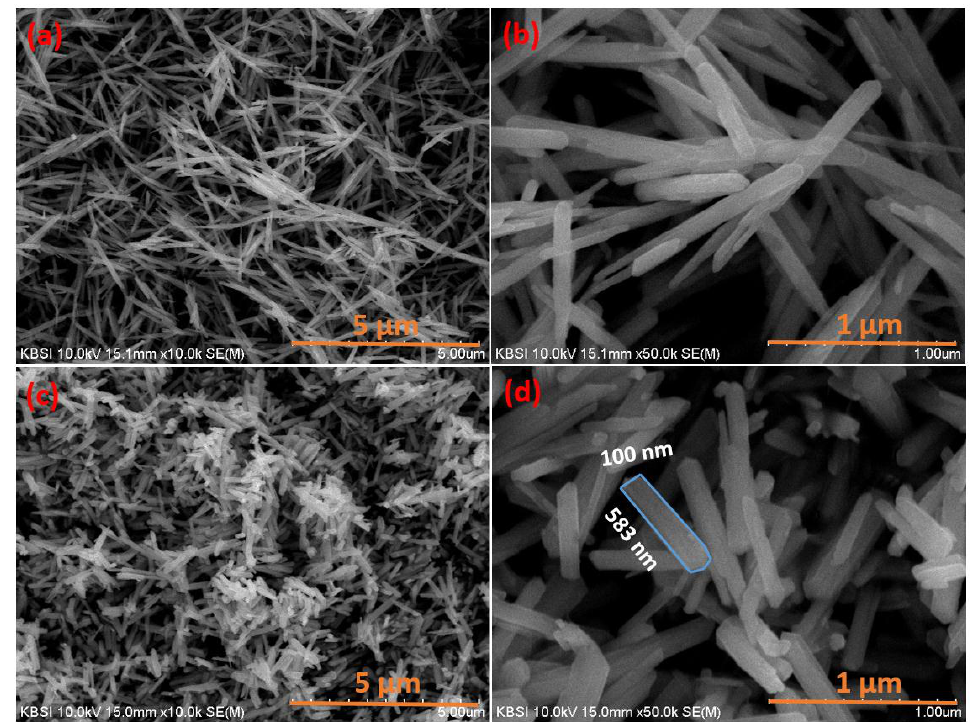
Figure 4. HR-SEM images: low magnification images of ( a ) MnS, ( c ) Cu-MnS and high-magnifications images of ( b ) MnS, ( d ) Cu-MnS.